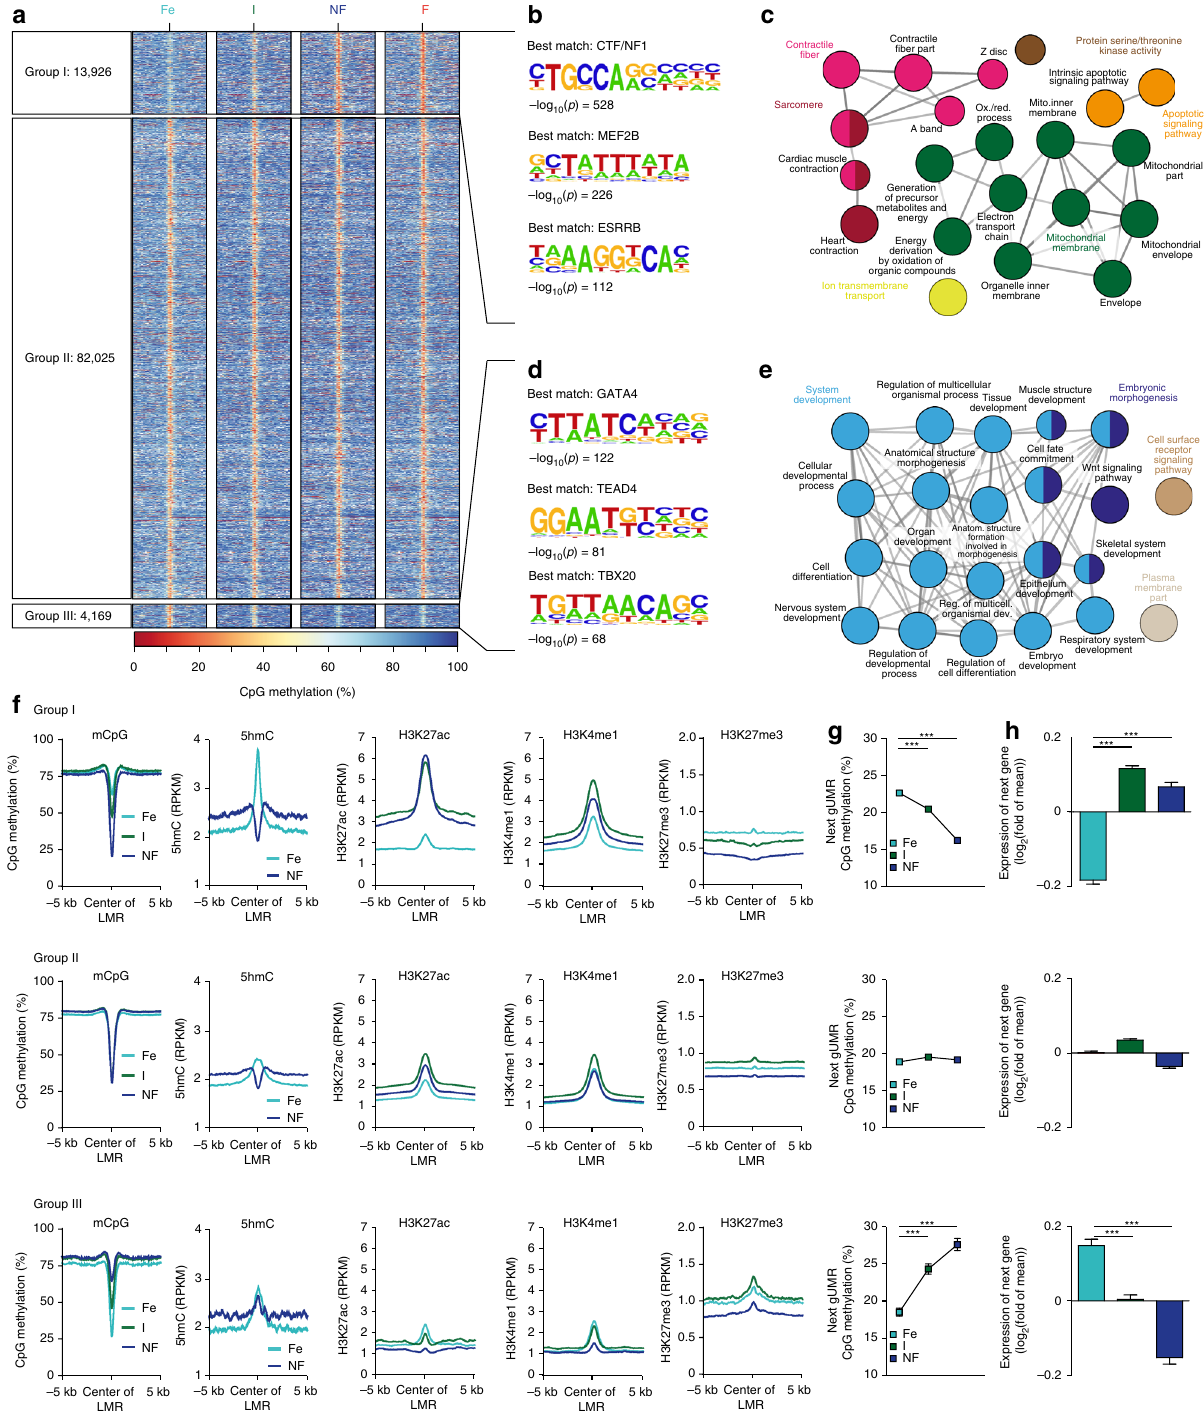
Fig. 4 mCpG of low methylated regions (LMR) during development and maturation of cardiac myocytes. a Heatmap of mCpG within LMRs. LMRs were clustered into three groups according to differential mCpG in fetal vs. non-failing adult cardiac myocytes Shown are 10 kb windows around the LMR center. a Group I contains DM-LMRs with a loss, group III by gain, and group II by no signi fi cant change in mCpG. b – e Transcription factor enrichment within LMRs ( b , d ) and Gene Ontology analysis of adjacent genes ( c , e ). The depicted GO terms were signi fi cantly enriched with Bonferroni step down corrected p - values < 10 – 2 . Given are HOMER transcription factor enrichment p -values. f Pro fi les of mean mCpG and enrichment of histone modi fi cations (H3K4me1, H3K9ac, H3K27ac, H3K27me3) at LMRs for groups I – III. g , h Next gUMR mCpG level ( g ) and relative gene expression of adjacent genes ( h ) (mean ± SEM). *** p < 0.001 by ANOVA. Figures show data from n biological replicates: mCpG, n = 3 – 5; H3K27ac, H3K9ac, H3K36me3, H3K4me1, H3K4me3, and H3K27me3, n = 3; 5hmC, pooled analysis from 2 – 5 biological samples, RNA, n = 3 –